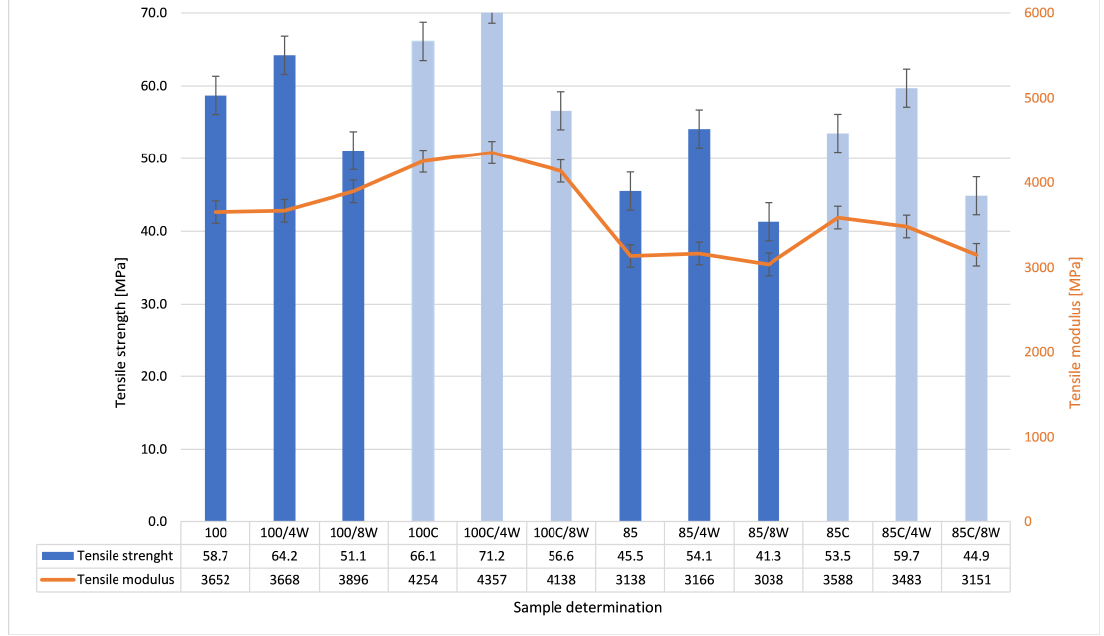
Figure 5. Comparison of mechanical properties examined during static tensile tests conducted at room temperature for pure, hydrolytically degraded and crystallized samples.